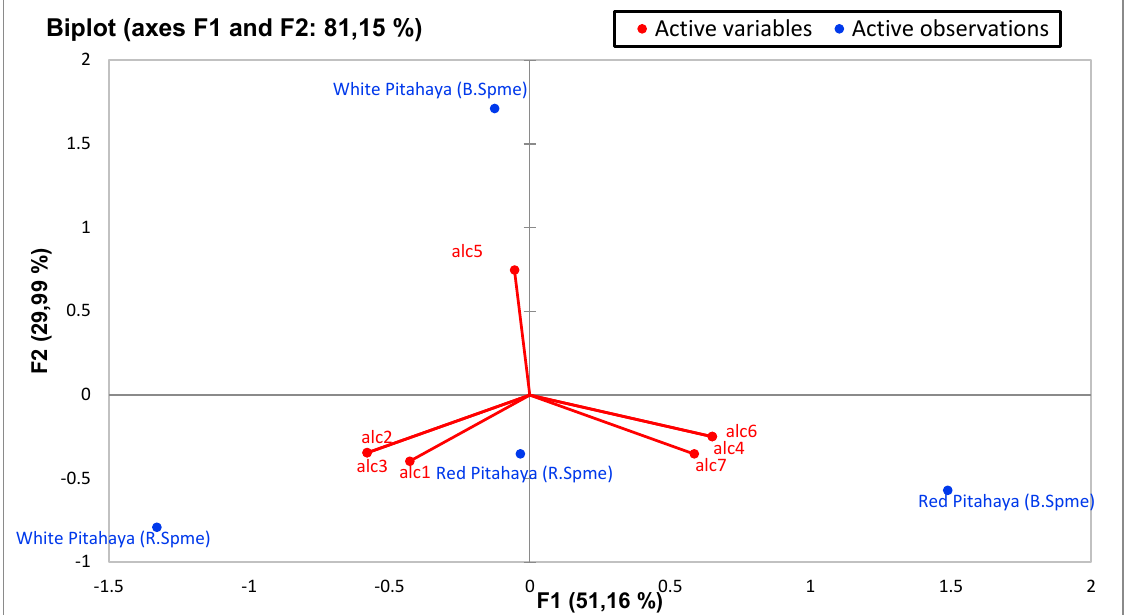
Figure 3. Biplot graph (scores and loading plots) obtained from Principal Component Analysis for Alcohols from volatile compounds in red-white pitaya. alc1: 1-Hexadecanol, alc2: 1-Tetradecanol, alc3: dimethyl-Silanediol, alc4: <2-ethyl->Hexanol, alc5: Lauryl alcohol, alc6: Pentadecanol, alc7: Tridecyl alcohol.